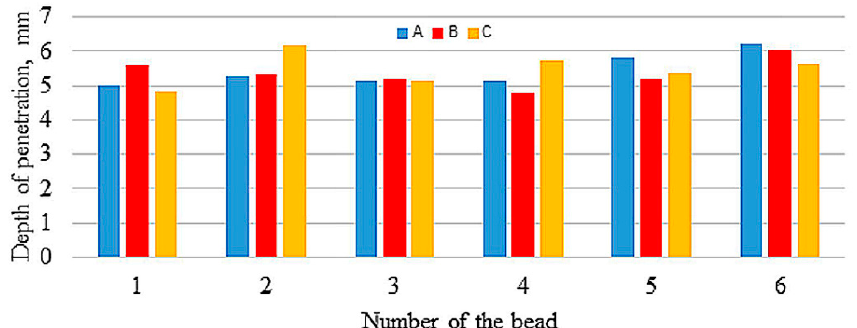
Figure 4. Penetration depth of particular beads.